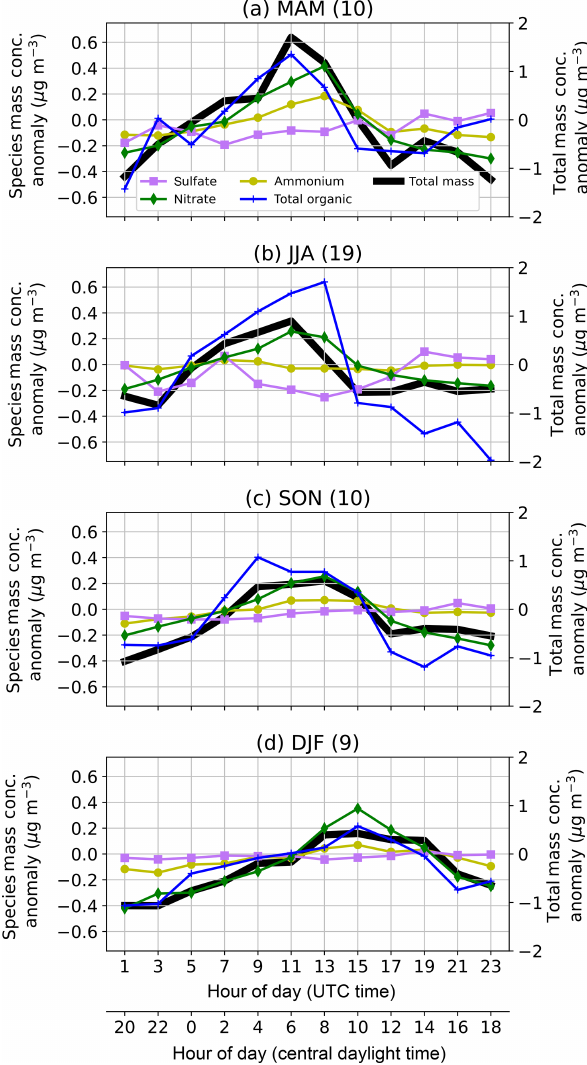
Figure 11. Normalized frequency of the daily time of peak con- centrations associated with the 24h cycle in the different modes of the aerosol volume size distribution. (a) – (d) represent V 7 − 30nm , V 30 − 140nm , V 140 − 800nm , and V 800nm + , respectively. The descrip- tion of the figure is the same as in Fig. 6.